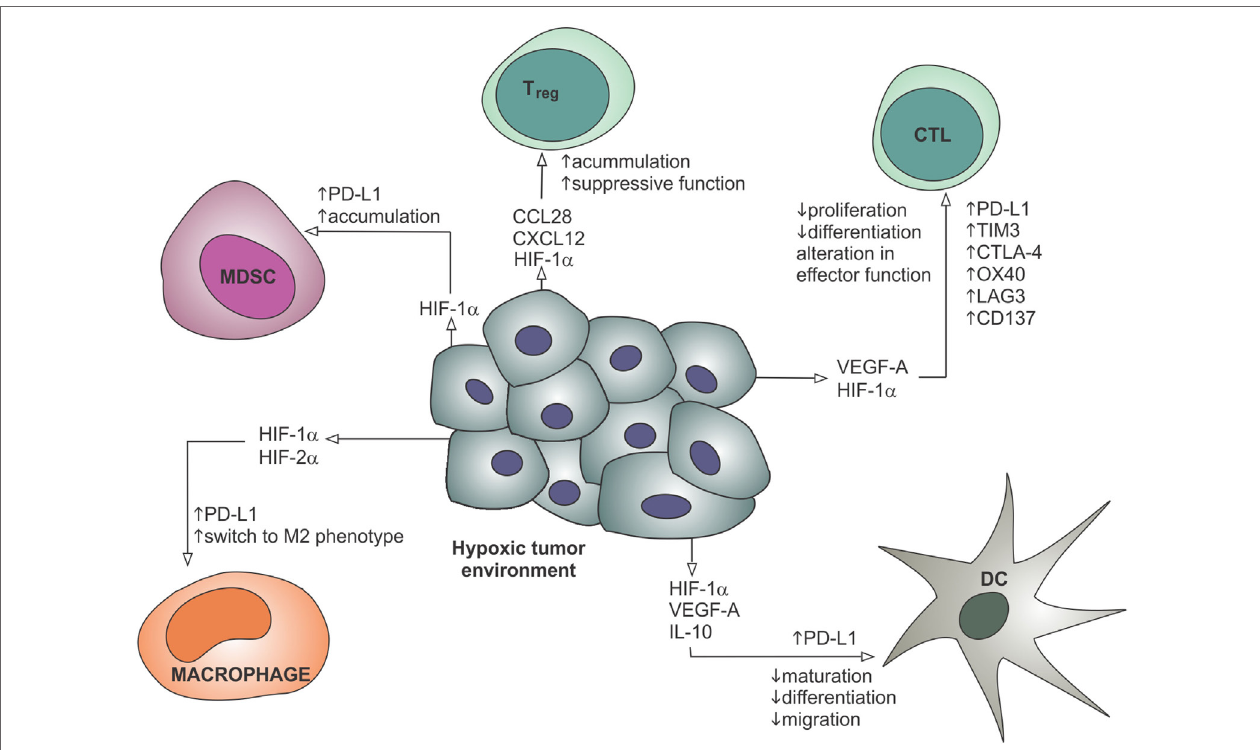
FigURe 3 | Hypoxia contributes to the recruitment of suppressive immune cells, restricts the maturation and migration of dendritic cells, reduces proliferation and differentiation of effector CTLs, and leads to the upregulation of immune checkpoint molecules such as PD-L1 . These effects are mediated through gene regulation by hypoxia-inducible factors and secreted factors such as VEGF-A. CTL, cytotoxic T lymphocyte; DC, dendritic cell; HIF, hypoxia-inducible factor; IL-10, interleukin-10; MDSC, myeloid-derived suppressor cell; T reg , regulatory T cell; VEGF-A, vascular endothelial growth